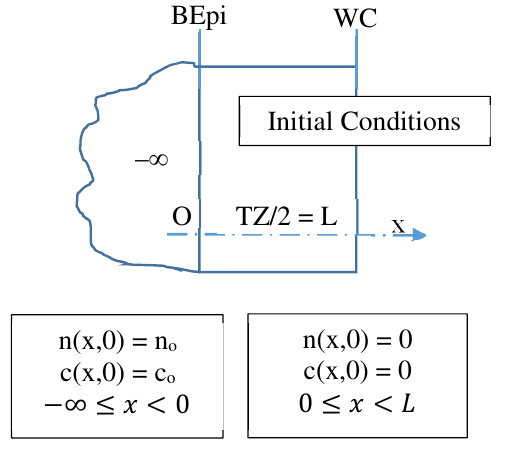
Fig. 3. Initial and Boundary Conditions selected. BEpi = Boundary of Epithelium, WC = Wound